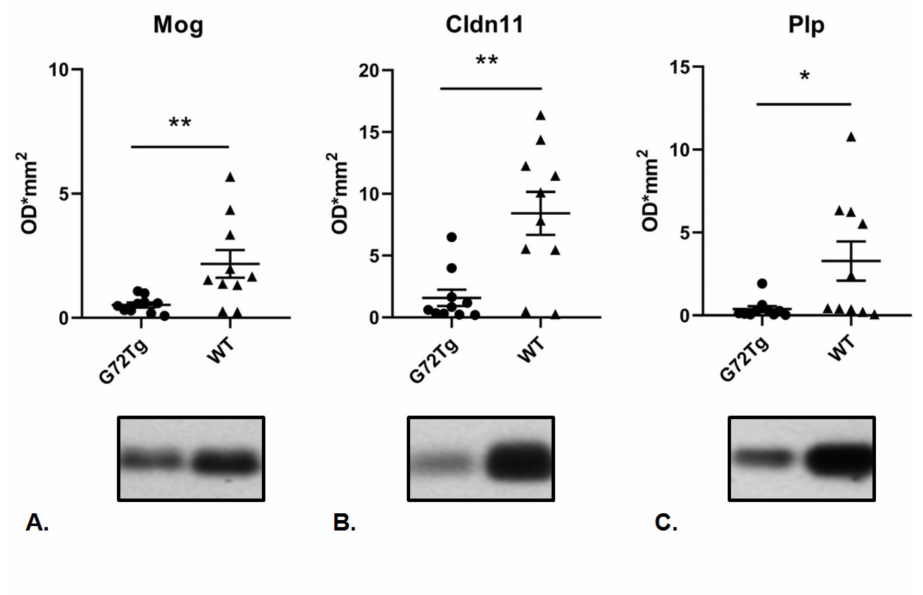
Figure 4. Decreased expression of myelin proteins in G72Tg compared to WT hippocampi. De- creased expression of ( A ) Mog (** p = 0.0089) ( B ) Cldn11 (** p = 0.0089) and ( C ) Plp (* p = 0.0147) in the cytoplasm of G72Tg ( n = 10) compared to WT ( n = 10) hippocampi. Data are presented as mean ± standard error of the mean